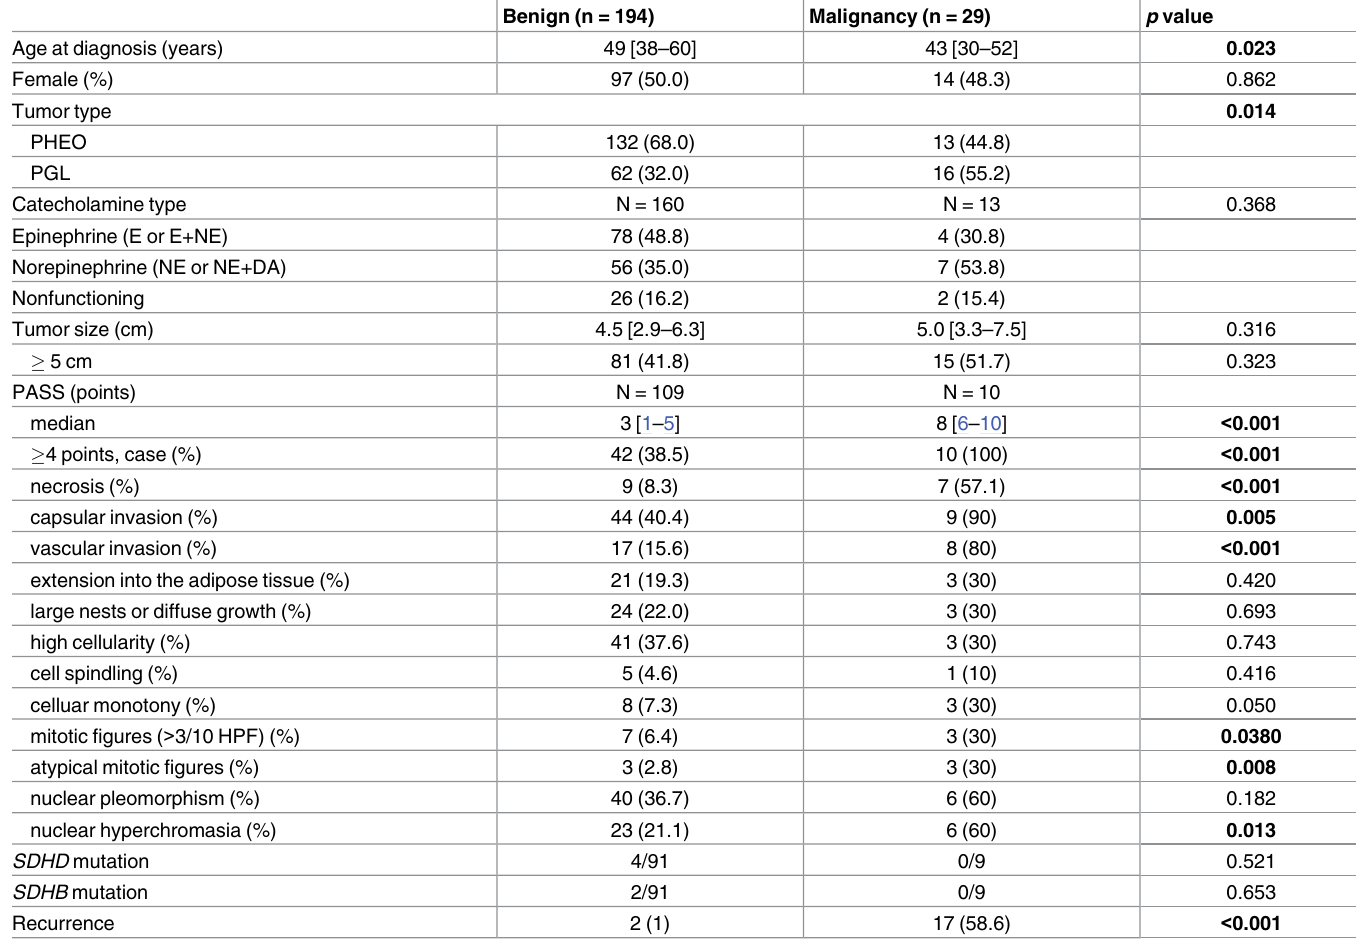
Table 2. Clinical and pathologic characteristics in patients with benign and malignant